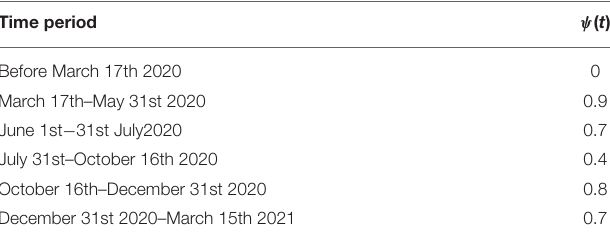
TABLE 1 | Adopted values for transmission rate mitigation factor based on social measures (Belgium). Time